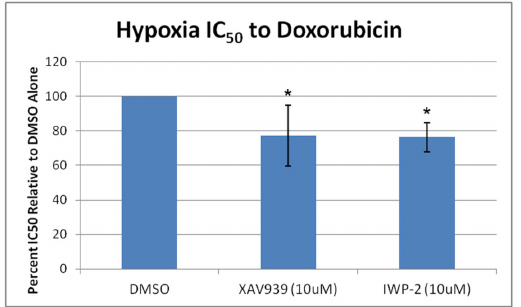
Figure 5. Further Wnt/ b -catenin signaling inhibition sensitizes hypoxic OS cells to doxorubicin. MG-63 OS cells were treated with increasing concentrations of doxorubicin under hypoxic conditions in the presence of the tankyrase inhibitor XAV939, the porcupine inhibitor IWP-2, or DMSO alone. Half maximal inhibitory concentrations (IC 50 ) were calculated, and the percent IC 50 relative to DMSO alone was determined. Asterisks indicate statistical significance (*p , 0.05).